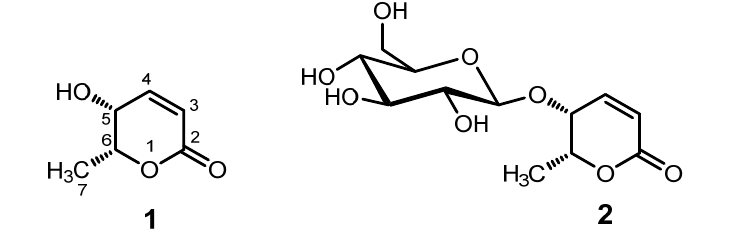
Figure 2. Structures of ( − ) ‐ epi ‐ osmundalactone ( 1 ) and angiopteroside ( 2 ). Table 1. 1 H and 13 C NMR data of compound 1 and 2 in DMSO ‐ d 6.